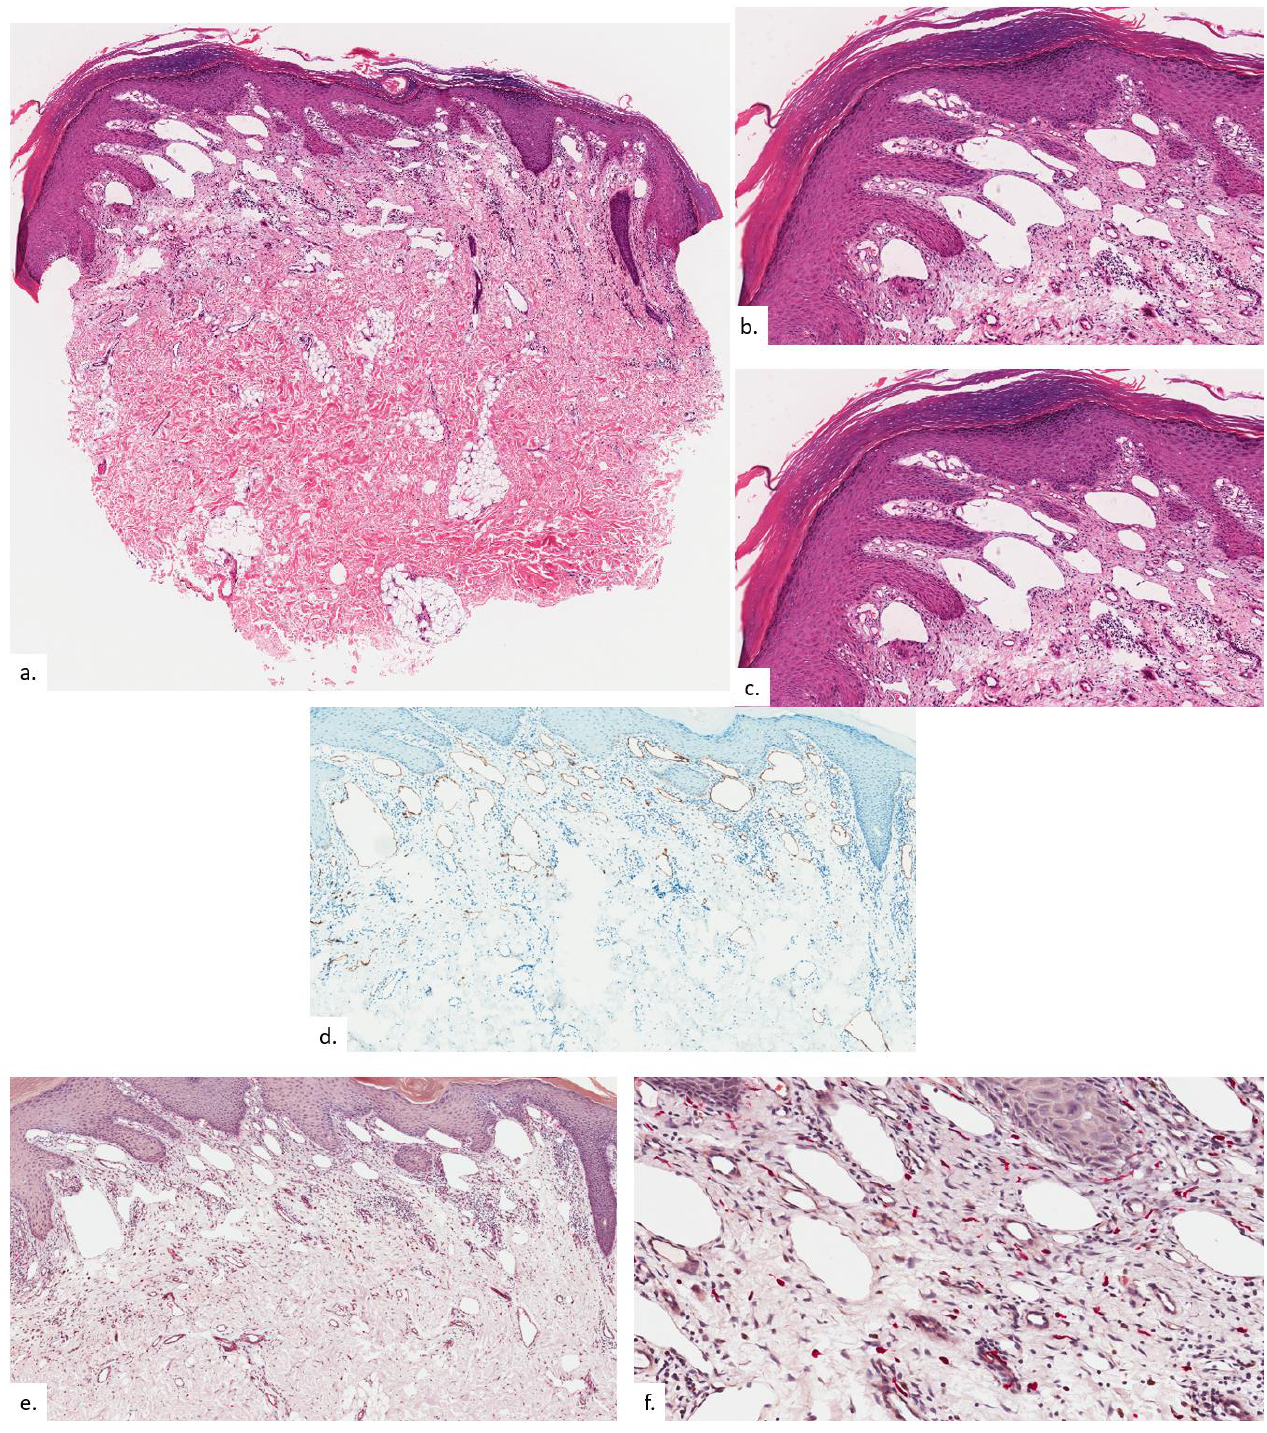
Figure 4. Patient 2. ( a , b ) There is compact hyperkeratosis and psoriasiform hyperplasia of the epidermis with hypergranulosis; ( c ) there was a vascular proliferation within the upper to mid dermis, consisting of a greater proportion of lymphatic channels than blood vessels, as seen on podoplanin ( d ); ( e , f ) MC numbers were significantly elevated as highlighted on CAE. The third patient is a 68-year-old Chinese male with a history of foot eczema. He presented with a right buttock lump of 3 months duration. There was some discomfort in sitting. There had been some improvement with previous cryotherapy and the use of